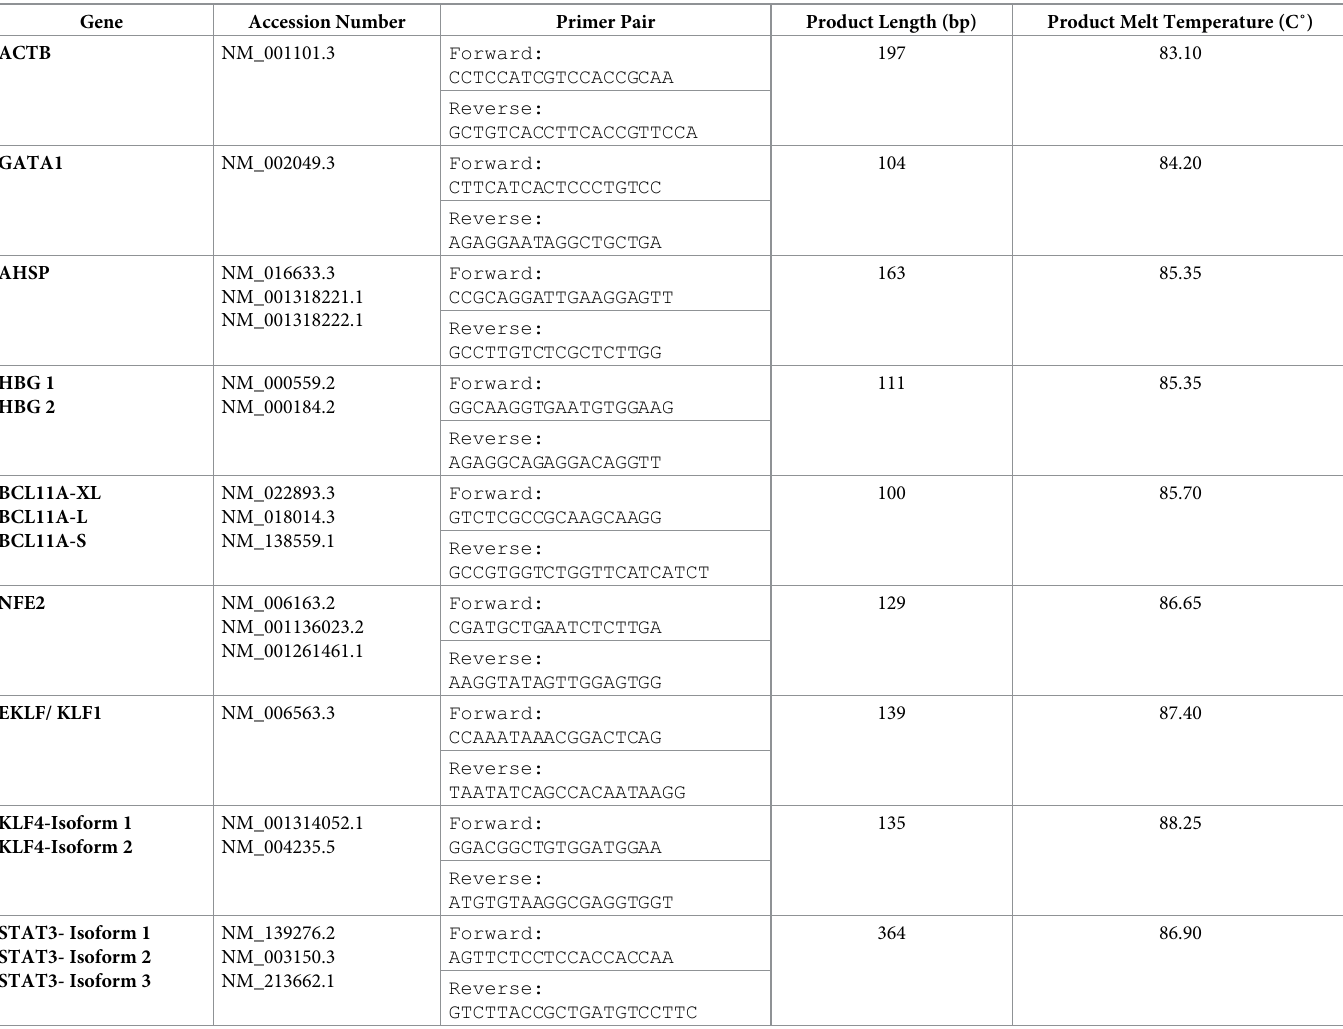
Relative real-time qRT-PCR Real-time qRT-PCR reactions were performed in QIAGEN’s real-time PCR cycler (Rotor- Gene Q) (QIAGEN, Germany) with SYBR Green PCR Master Mix (SYBR Premix Ex Taq™ II, Tli RNaseH Plus) (TaKaRa, Japan). The real-time qRT-PCR reaction (total volume of 20 μl) contained 0.3 μM forward and reverse primers, 1X SYBR Premix Ex Taq II, and 1 μl (100 ng) cDNA. The amplification profile involved initial denaturation at 95 ˚C /30 seconds and 40 cycles of denaturation at 95 ˚C/5 seconds, annealing at 57 ˚C/30 seconds, and elongation at 72 ˚C/30 seconds, followed by a melting curve stage. The real-time qRT-PCR reaction was per- formed for all genes of interest as targets and β -actin (ACTB) as the endogenous reference gene for each sample. Table 1 shows the list of target genes and sequences of the primer pairs for each gene. Each set of reactions included a negative control minus RT Enzyme and another without cDNA (NTC). All reactions, including the no-template control (NTC),